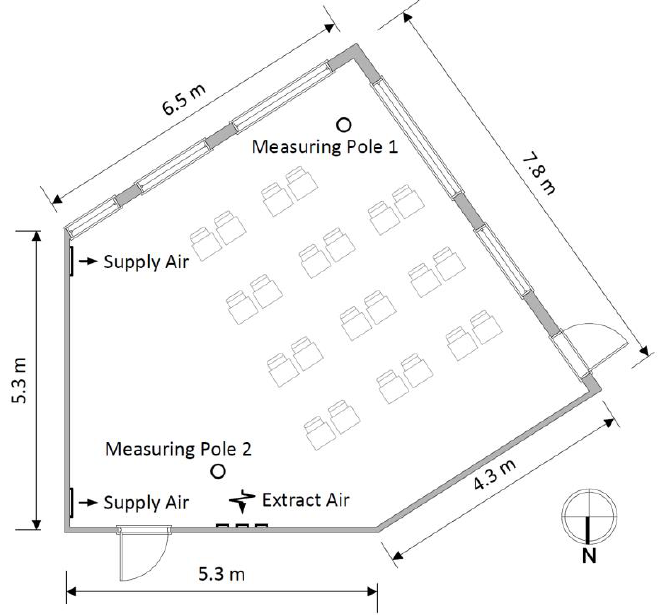
Figure 7. Floor plan of the classroom with measurement points.